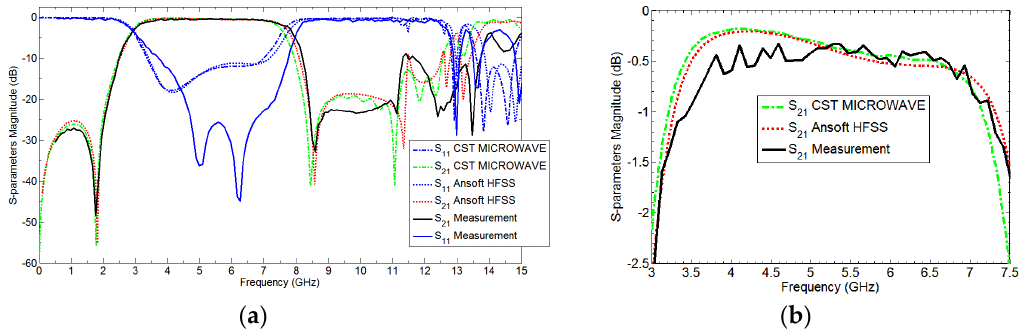
Figure 11. ( a ) Measured and Simulated frequency response of the SCSRR based miniaturized bandpass filter; ( b ) Zoom-in of part ( a ) from 3 GHz to 7.5 GHz.